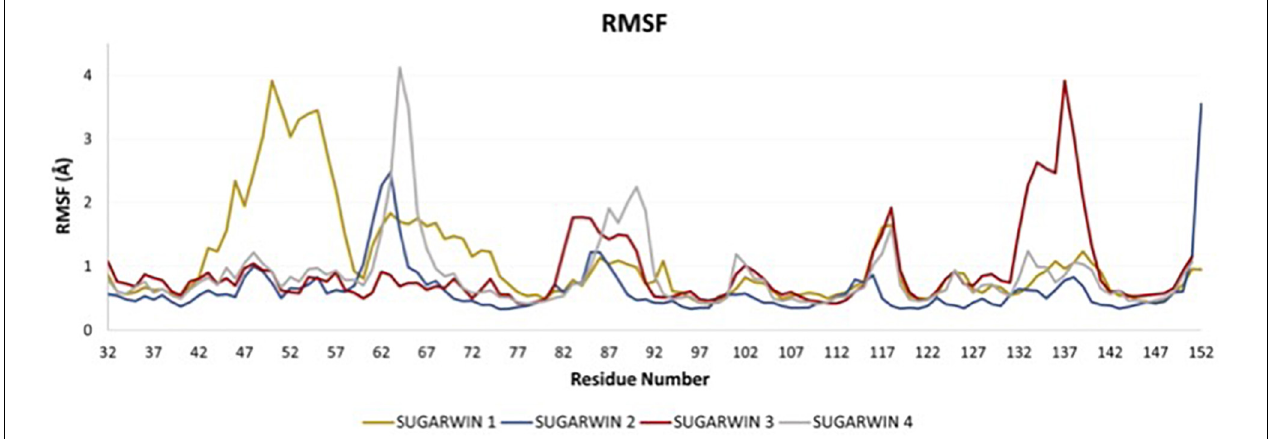
FIGURE 6 | RMSF of the SUGARWINs. Root mean square fluctuation (RMSF) analysis for SUGARWINs 1, 2, 3 and 4 as derived from molecular dynamics simulations. Residues are numbered in reference to SUGARWIN1 complete